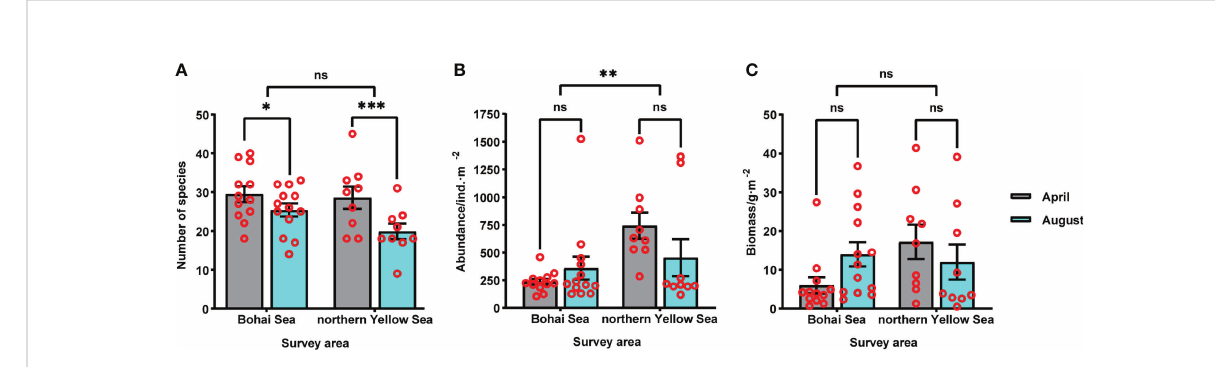
FIGURE 2 (A) Species numbers, (B) abundance, and (C) biomass of macrobenthos, in April and August of 2020, in the Bohai Sea and northern Yellow Sea areas off Yantai, China. Asterisks denote an highly signi fi cant difference (*** p < 0.001, ** p < 0.01) or a signi fi cant difference (* p < 0.05); ns represents no signi fi cant difference.